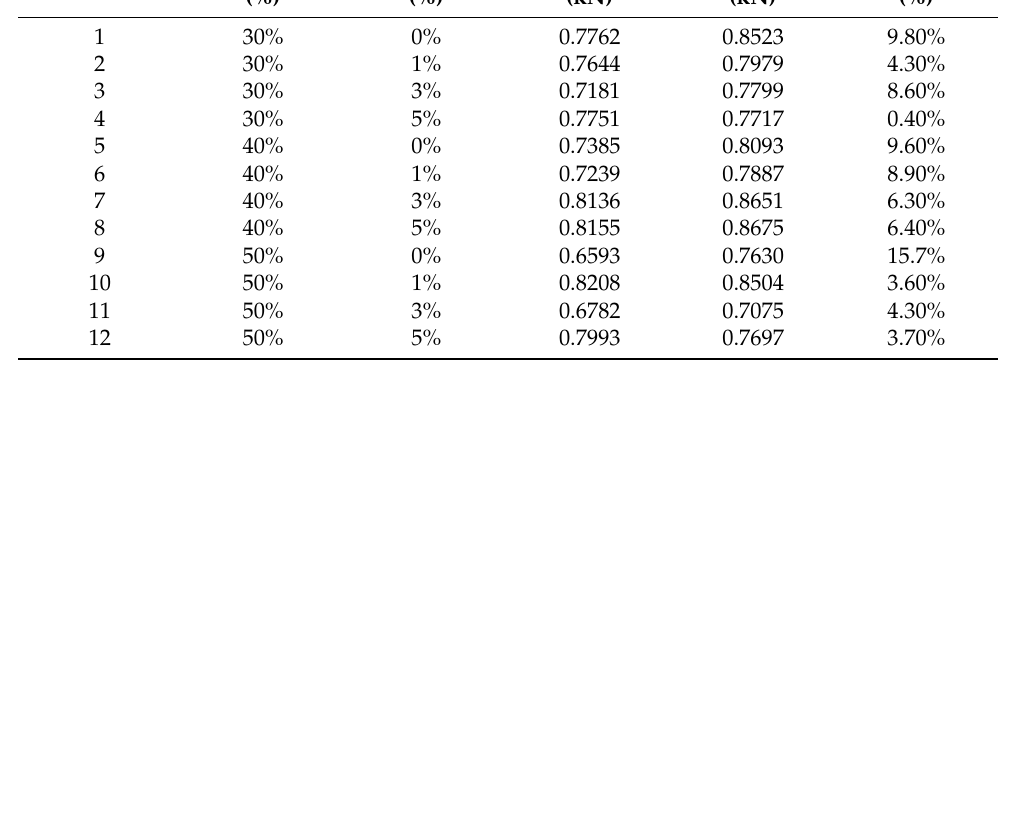
Table 10. Comparison of failure force obtained in the experimental and numerical tensile test.